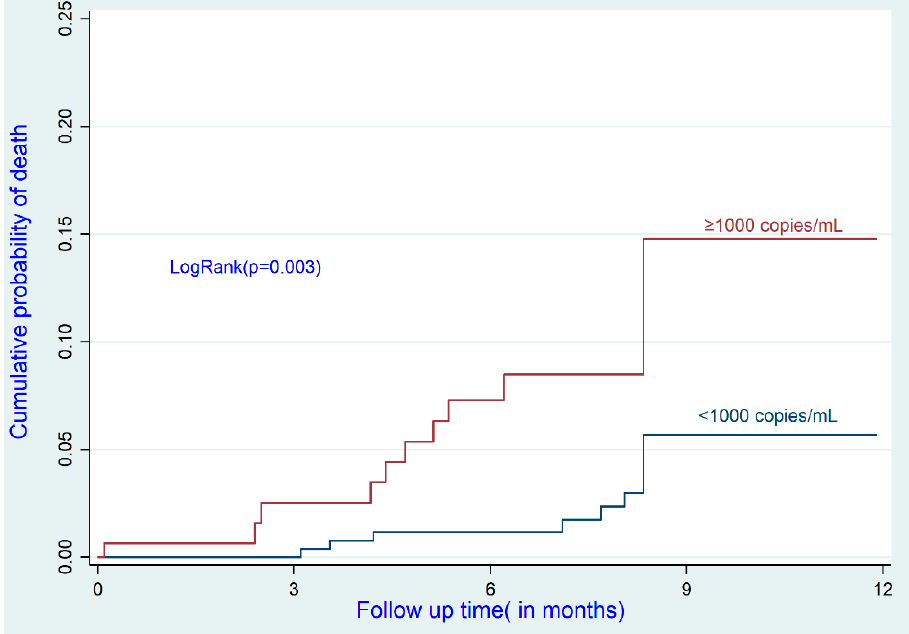
Figure 2. Cumulative incidence of death by status of treatment before enrollment.